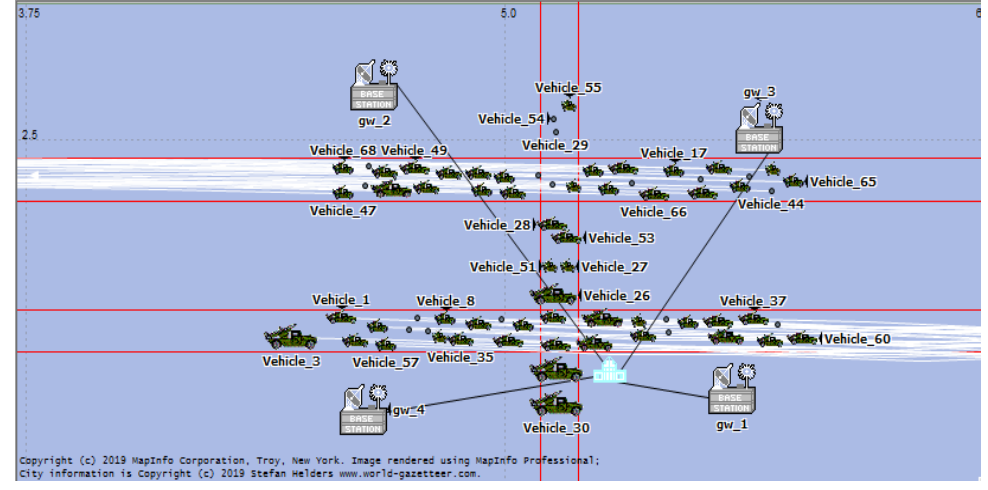
Figure 5. Simulation